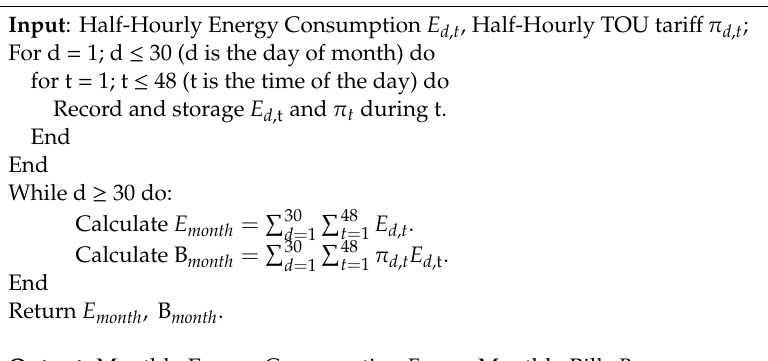
Algorithm 1 Dynamic TOU billing